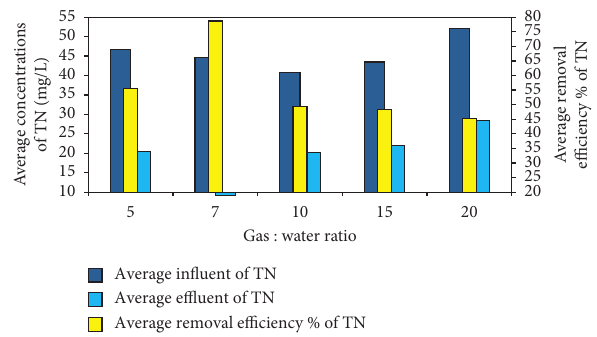
Figure 9: Effect of gas : water ratio on the average TN removal.